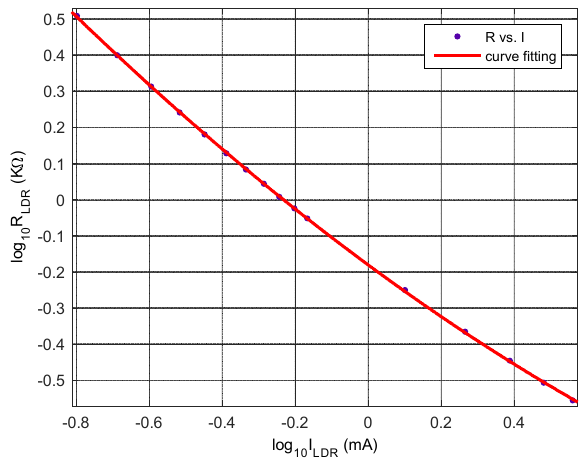
R versus LED current. LDR